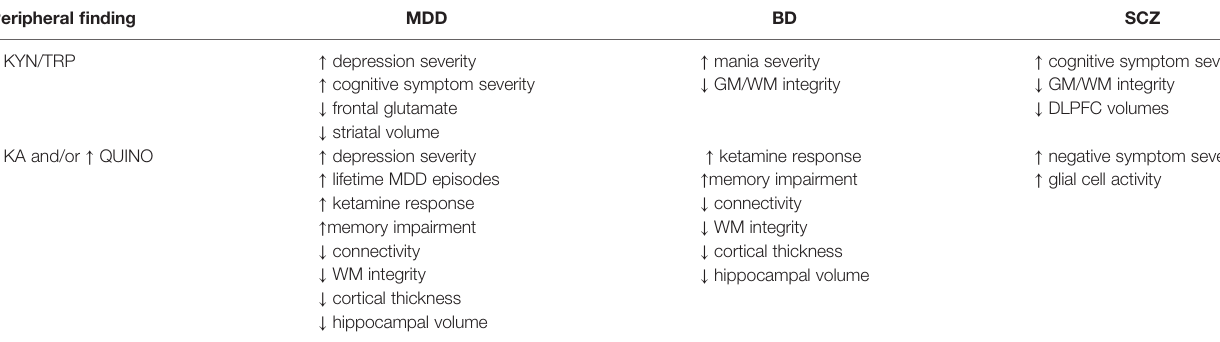
TABLE 2 | Effects of KP changes on symptomatology and biomarkers in psychiatric illness. Peripheral fi nding MDD BD ↑